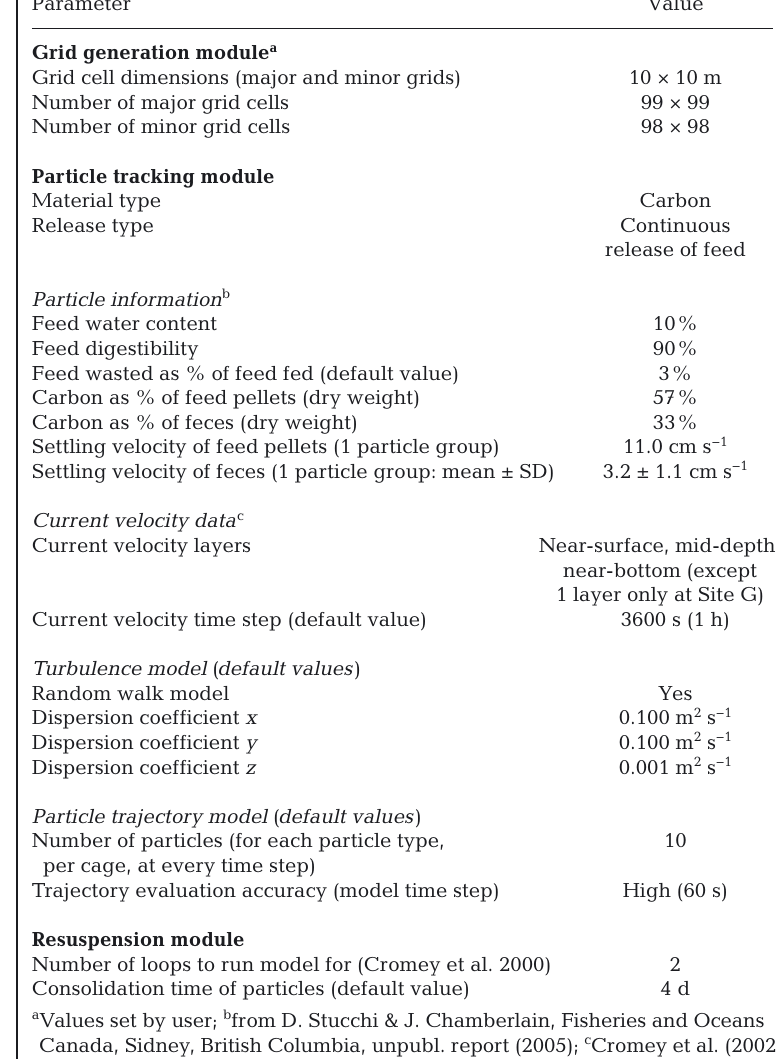
Table 3. DEPOMOD input